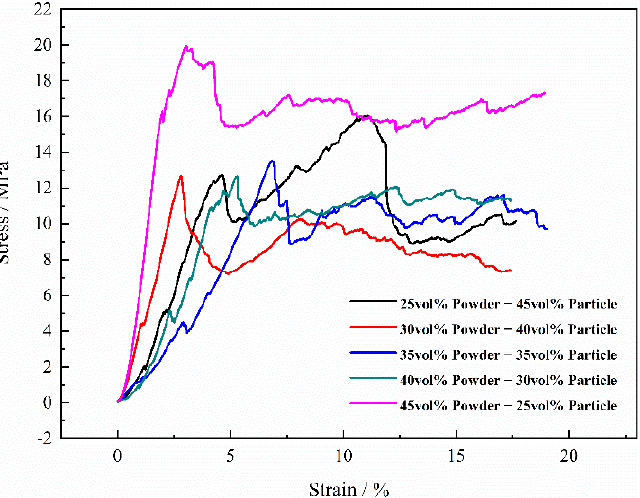
Figure 19. Curves of engineering strain-stress of porous titanium with different volume percentage of the magnesium powders and the magnesium particles.